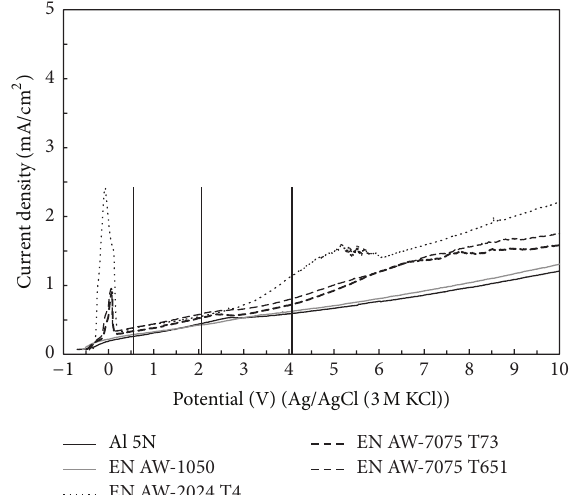
Figure 1: I/V behaviour of Al 5 N, EN AW-1050, EN AW-2024 T4, EN AW-7075 T73, and EN AW-7075 T651 during potentiodynamic anodising in 0.4 M sulphuric acid using the micro-capillary tech- nique; vertical lines mark the potentials selected for potentiostatic anodising (as shown in Figures 4 and